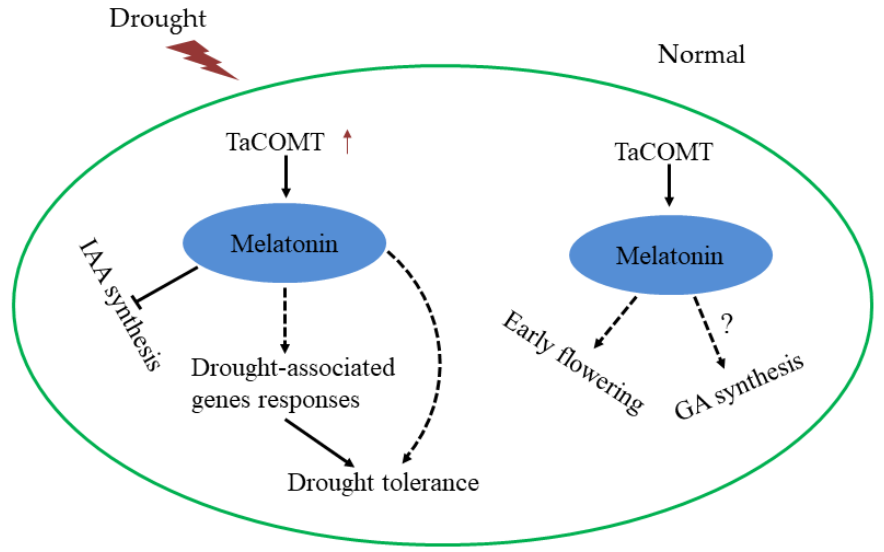
Figure 8. Proposed mechanisms of overexpression of TaCOMT to enhance drought tolerance and participate in GA and IAA Pathway in Arabidopsis. Under drought condition, the expression of TaCOMT increased melatonin synthesis in plants. The increasing of melatonin content leads to the decrease of IAA level and the changing of transcription of drought-related genes, and, then, enhancing drought tolerance in plants. The increasing of melatonin content can also improve the drought tolerance of plants. Under normal conditions, overexpression of TaCOMT increased the content of melatonin in plants. High levels of melatonin promoted early flowering and involved in the GA pathway.